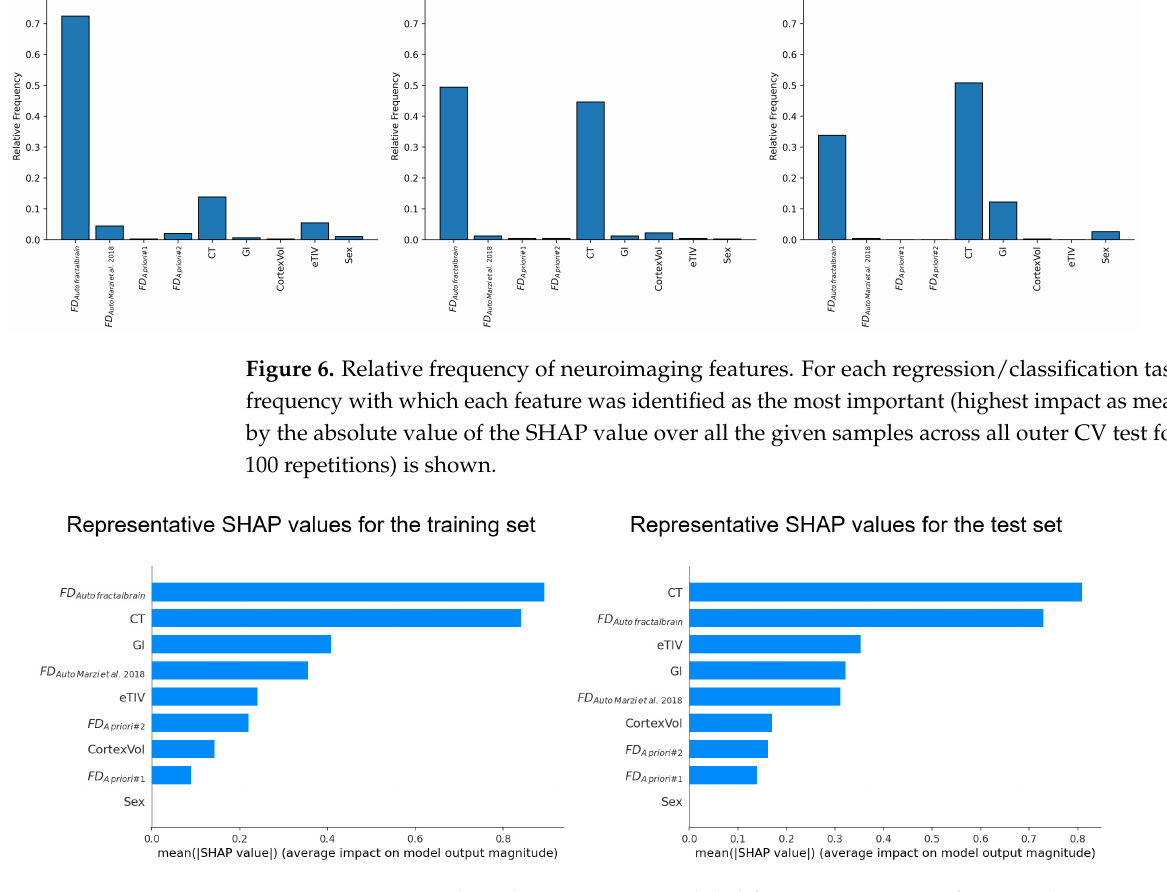
Figure 7. Summary bar plot representing global feature importance for a single iteration of the regression task using the NKI dataset, separately, for the training (on the left ) and test sets (on the right ). The order of the most impactful features in one iteration differs between training and test